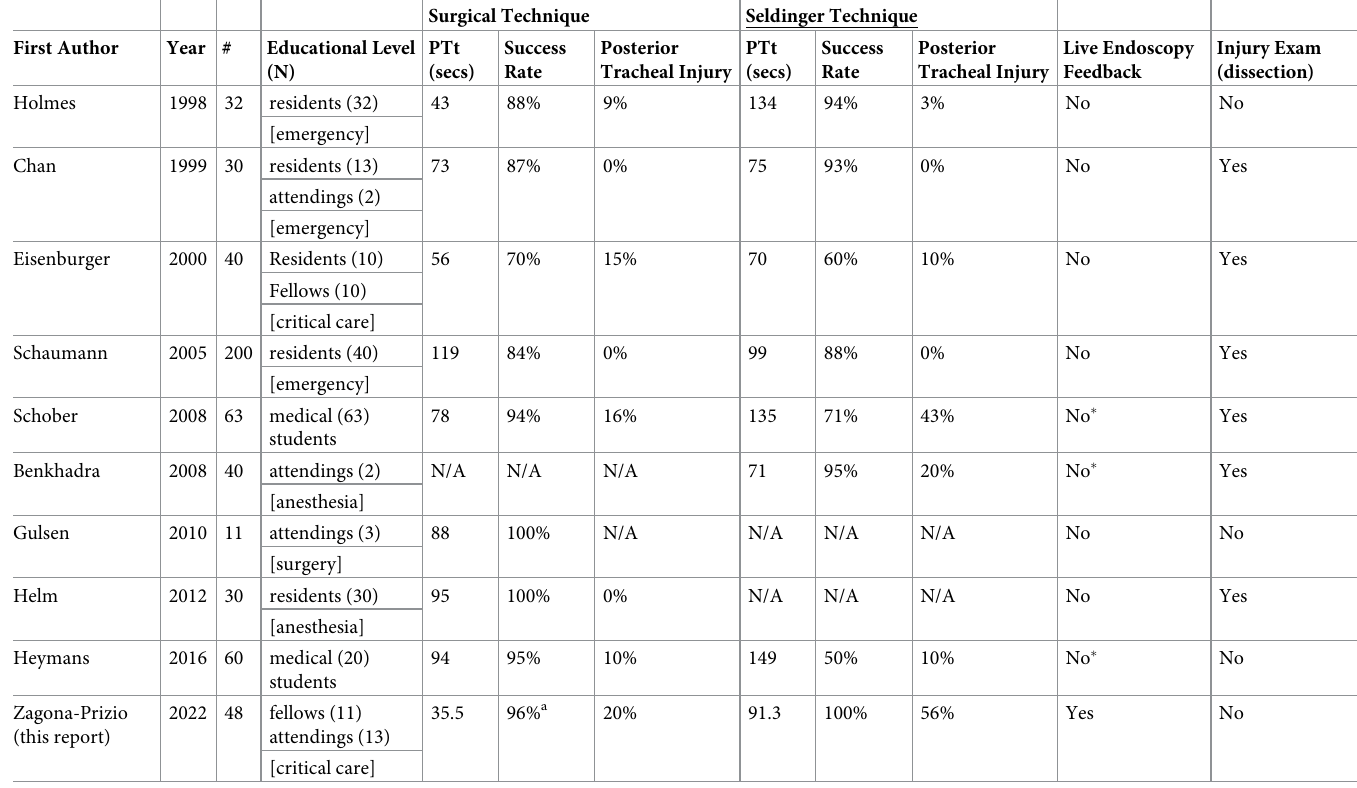
Table 2. Published cricothyrotomy training programs using human cadavers: Characteristics and data. Surgical